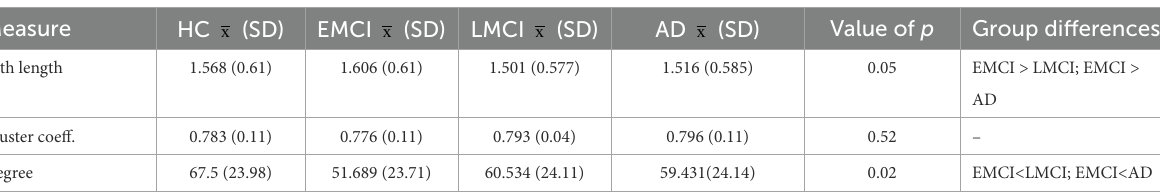
TABLE 3 Graph theory